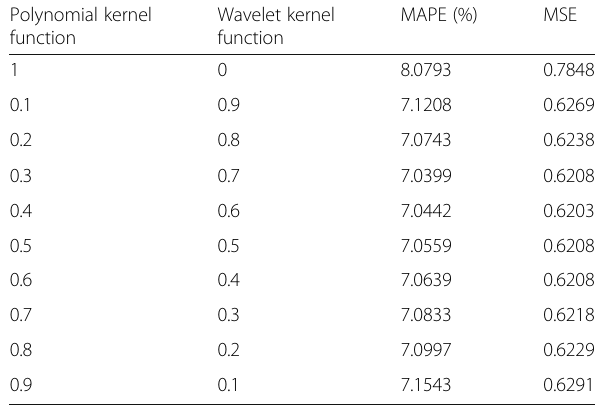
Table 1 The forecasting errors based on cross-validation